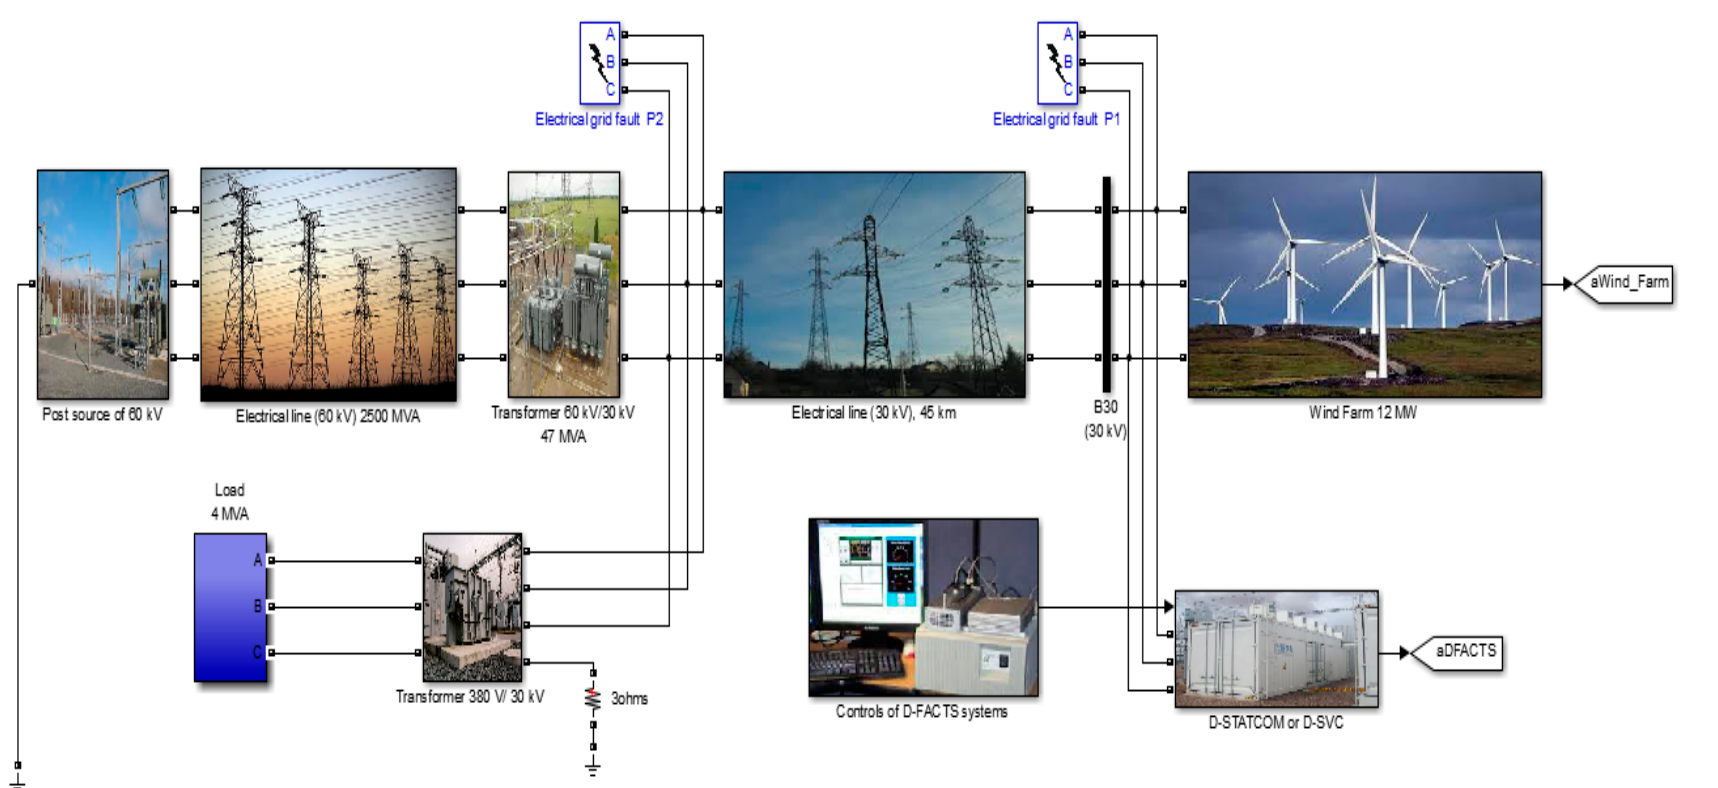
Figure 12. Block diagram of the proposed system on Matlab/Simulink.